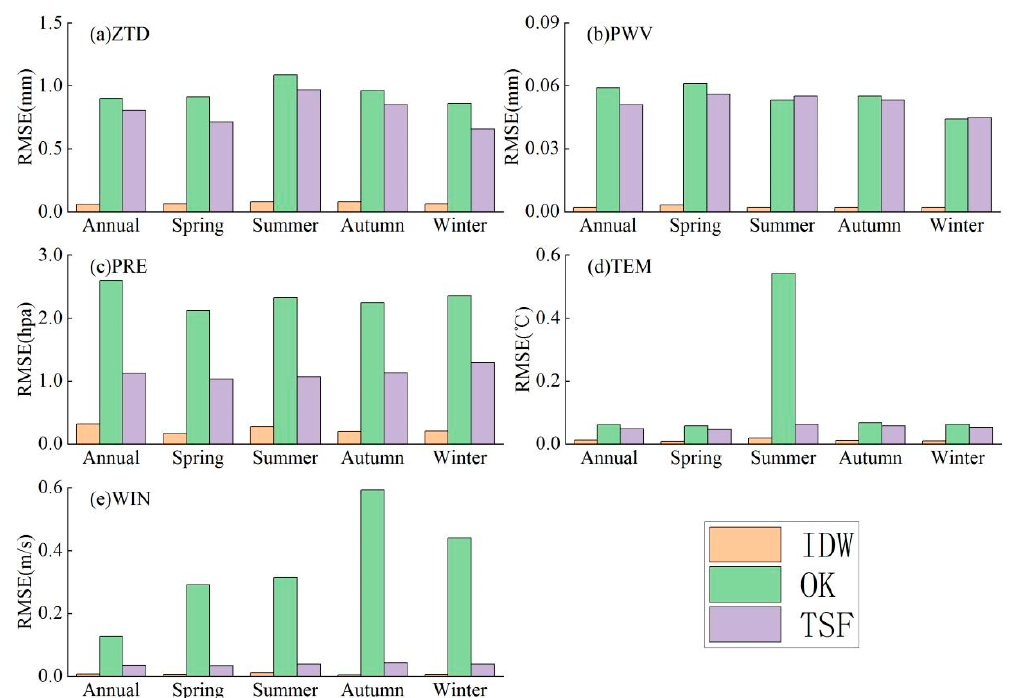
Figure 2. Interpolation effect comparison: ( a – e ) Results of root mean square error of three interpolation methods (IDW, OK, TSF) for interpolating five variables (ZTD, PWV, PRE, TEM and WIN) respectively. Note: DEM means the elevation values obtained from the digital elevation model, WIN means wind, PRE means pressure, TEM means temperature, ZTD means zenith tropospheric delay, PWV means precipitable water vapor, IDW means inverse distance weighting, OK means ordinary kriging, TSF means the tension spline function.